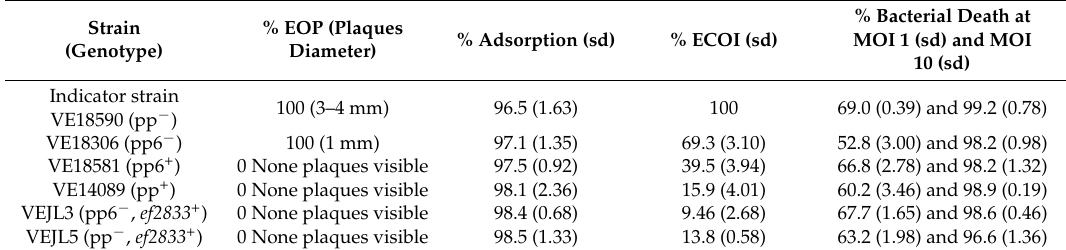
Table 2. Parameters of phage Idefix proliferation on E. faecalis strains differing by the presence or absence of prophage 6 or prophage 6-encoded